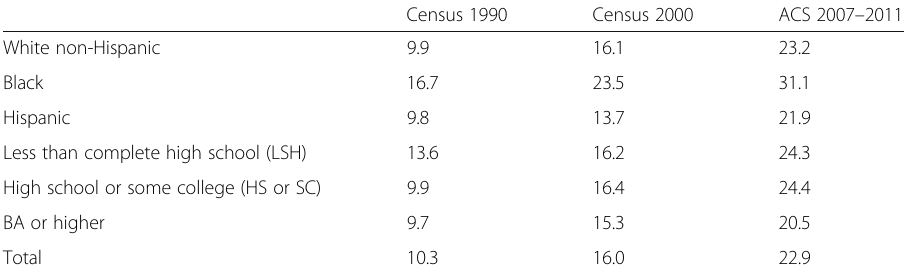
Table 3 USA: percent cohabiting among women 25 – 29 in union, 1990 – 2011, by race and